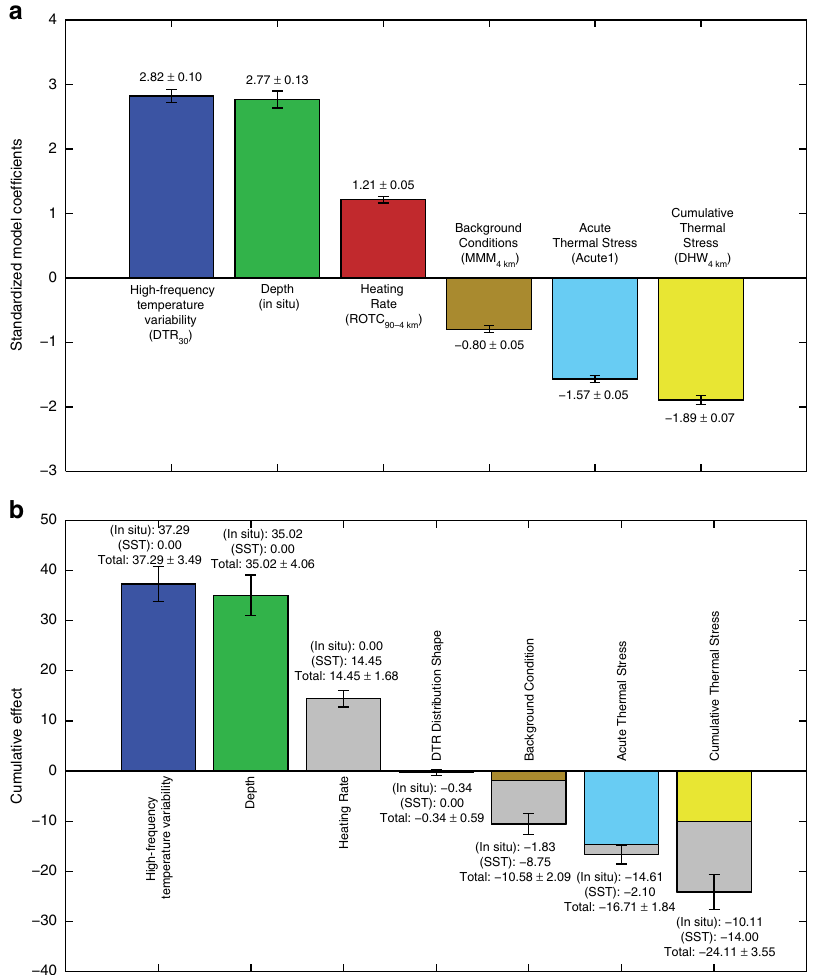
Fig. 5 Remotely sensed SST OLR results. a Parameter estimates for standardized model coef fi cients of the covariates used in the highest-ranked OLR model when weekly 4 km CoRTAD SST-based variables are added to the pool of possible covariates; standard error bars were computed from delete-1 jackknife resampling. b The summation of the standardized covariate coef fi cients grouped by category from the highest-ranked models when including CoRTAD SST-based covariates; the standard error bars shown are obtained by summing in quadrature the individual standard errors computed after delete-1 jackknife resampling. The remotely sensed SST-based covariate contribution to each Cumulative Effect is colored